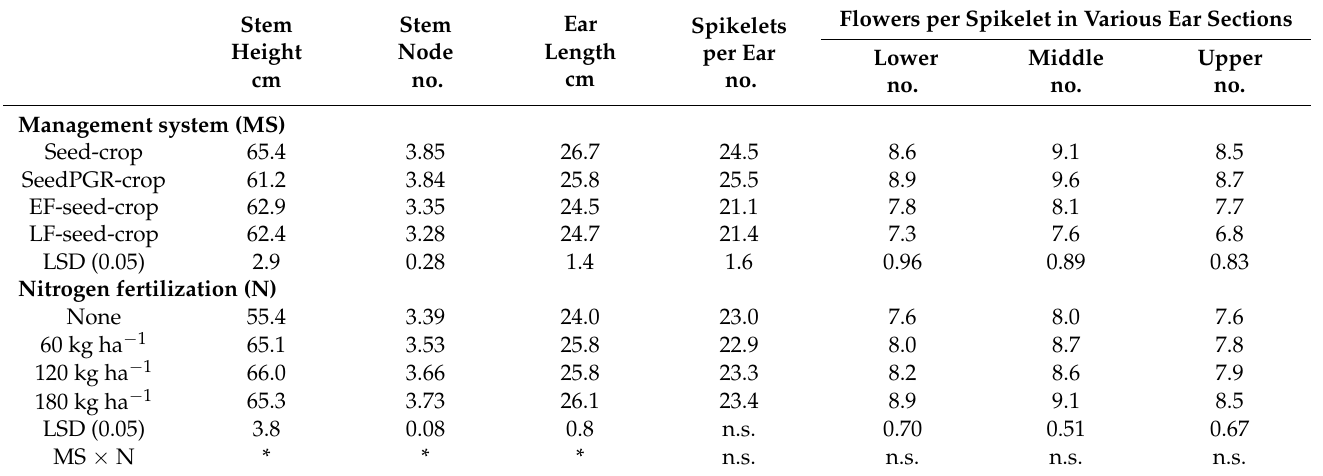
Table 4. Characteristics of early-formed reproductive tillers in Italian ryegrass crop as affected by management system and nitrogen